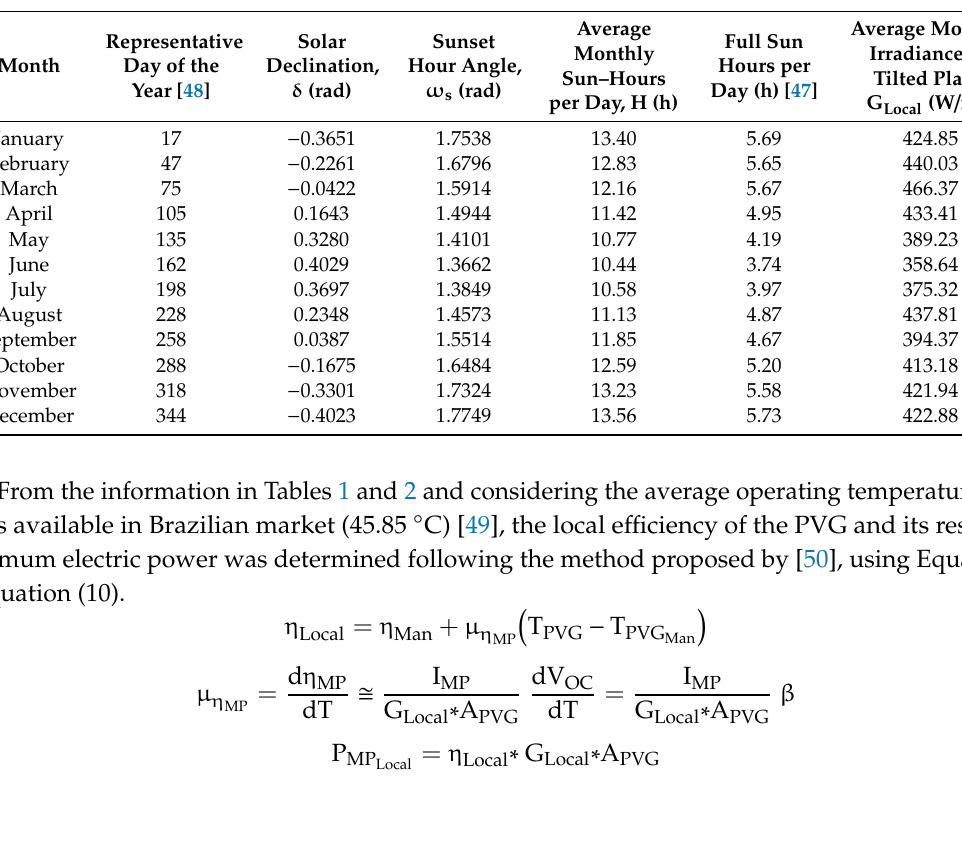
Table 2. Foz do Iguaçu City solar geometric